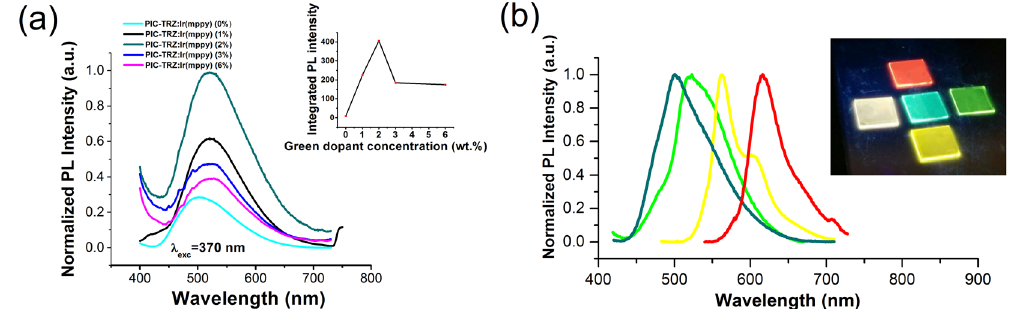
Figure 2. PL characterizations. ( a ) PL response with PIC:TRZ doped with different concentration of G.D.(x%), x = 0, 1, 2, 3 and 6. Inset shows the integrated PL intensity vs. concentration%. ( b ) PL spectrum of PIC:TRZ doped with different